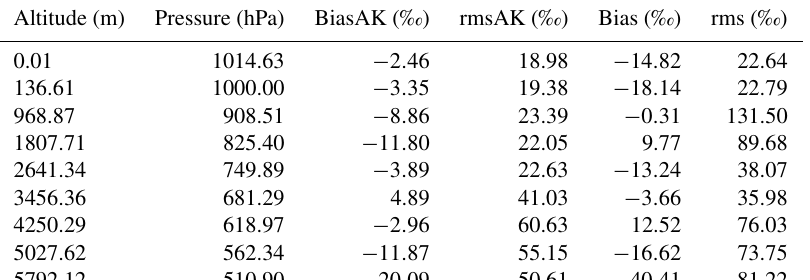
Table 2. Summary of satellite–aircraft comparisons for 110 matched pairs in 2016 (Fig. 2, closed circles). Bias and rms (standard deviation) of AIRS δ D relative to ORACLE aircraft, with averaging kernel applied (“BiasAK”, “rmsAK”), and for AIRS relative to mapped ORACLES aircraft, with no averaging kernel (“Bias”, “rms”). The reported rms here is the standard deviation, not including the bias. Altitude (m) Pressure (hPa) BiasAK (‰)